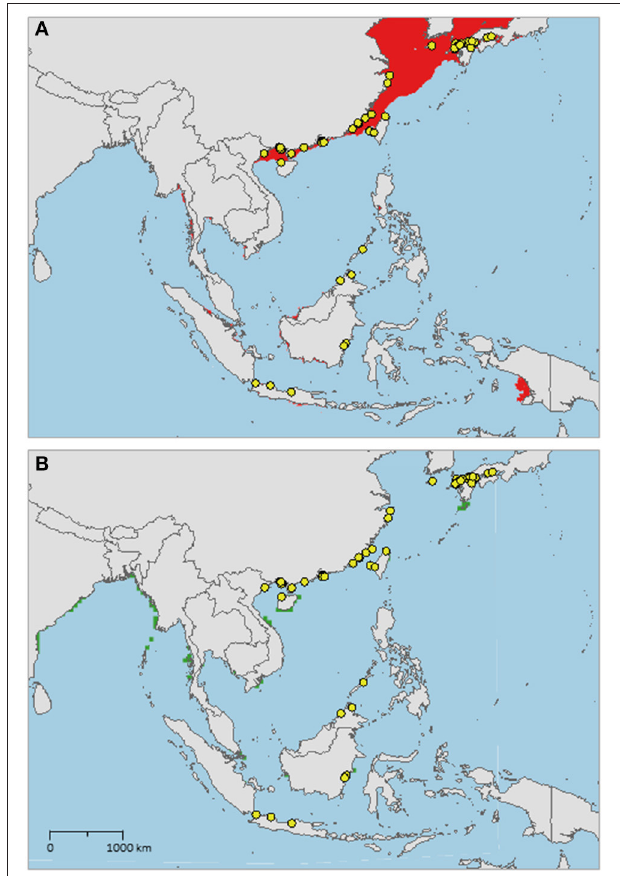
FIGURE 5 | Distribution maps for Tachypleus tridentatus with environmentally unique points, indicating the sampled distribution range for the species. Upper map (A) shows present-day projections of suitable habitat in red based on consensus of Maxent and SVM algorithms. Lower map (B) show changes between the present-day and 2050 projections of suitable habitat based of consensus of Maxent and SVM algorithms, with green cells indicating loss of suitable habitat and red cells indicating gain of suitable habitat. Support values for the individual models are given in Table 3